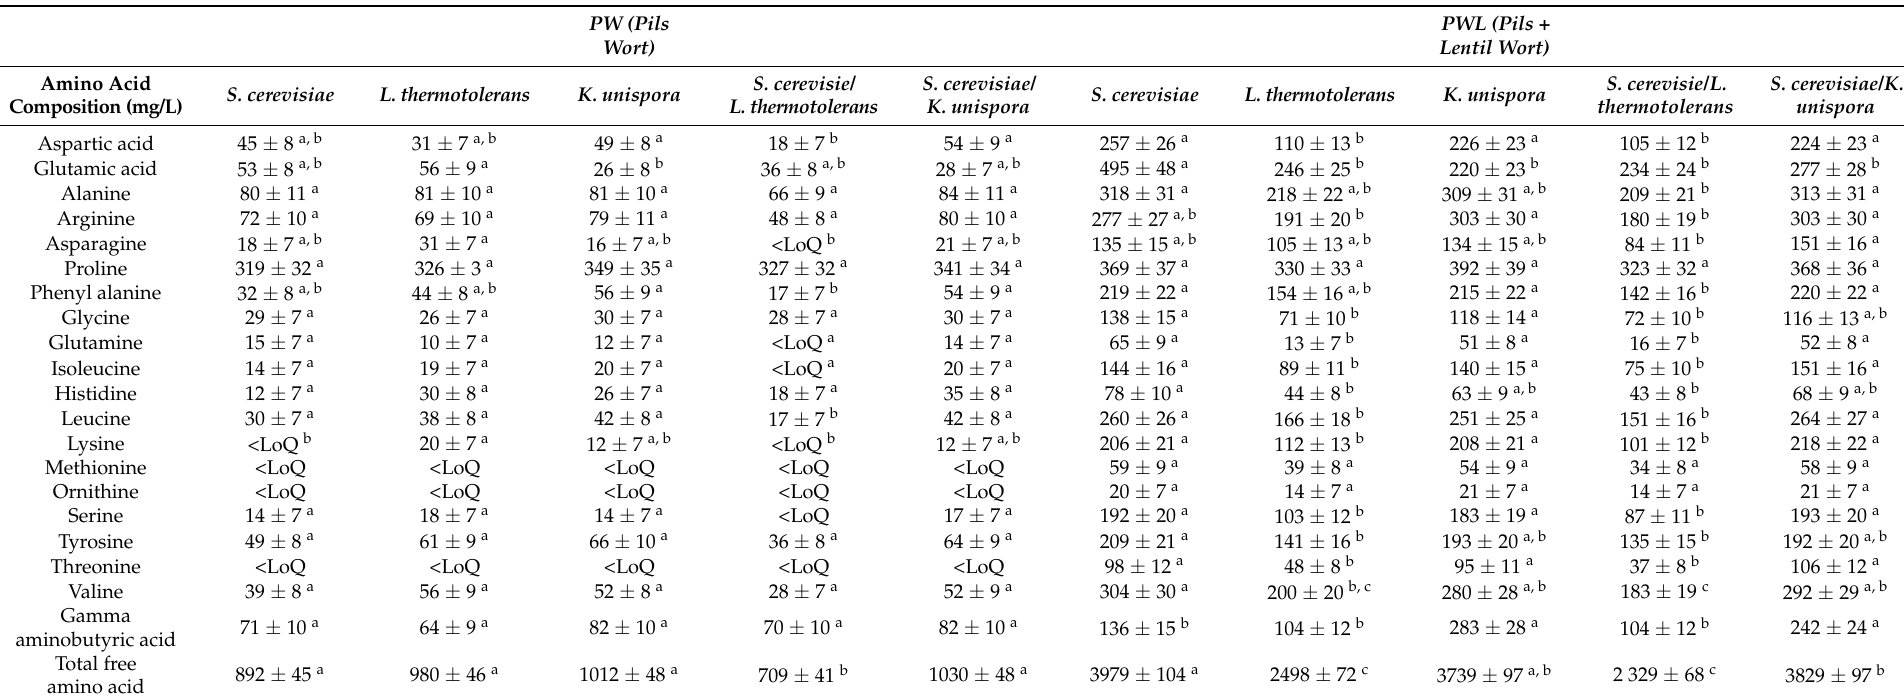
Table 2. Amino acid composition of final beers produced in pure and mixed fermentations on PW (pils wort) and (PWL) pils wort added with lentil. Data are means ± standard deviations from three independent experiments. Data with different superscript letters ( a, b, c ) within each row between the fermentation trials tested on the same wort (Duncan tests (0.05%). LoQ: limit of quantification (1 g/L). PW (Pils Wort)